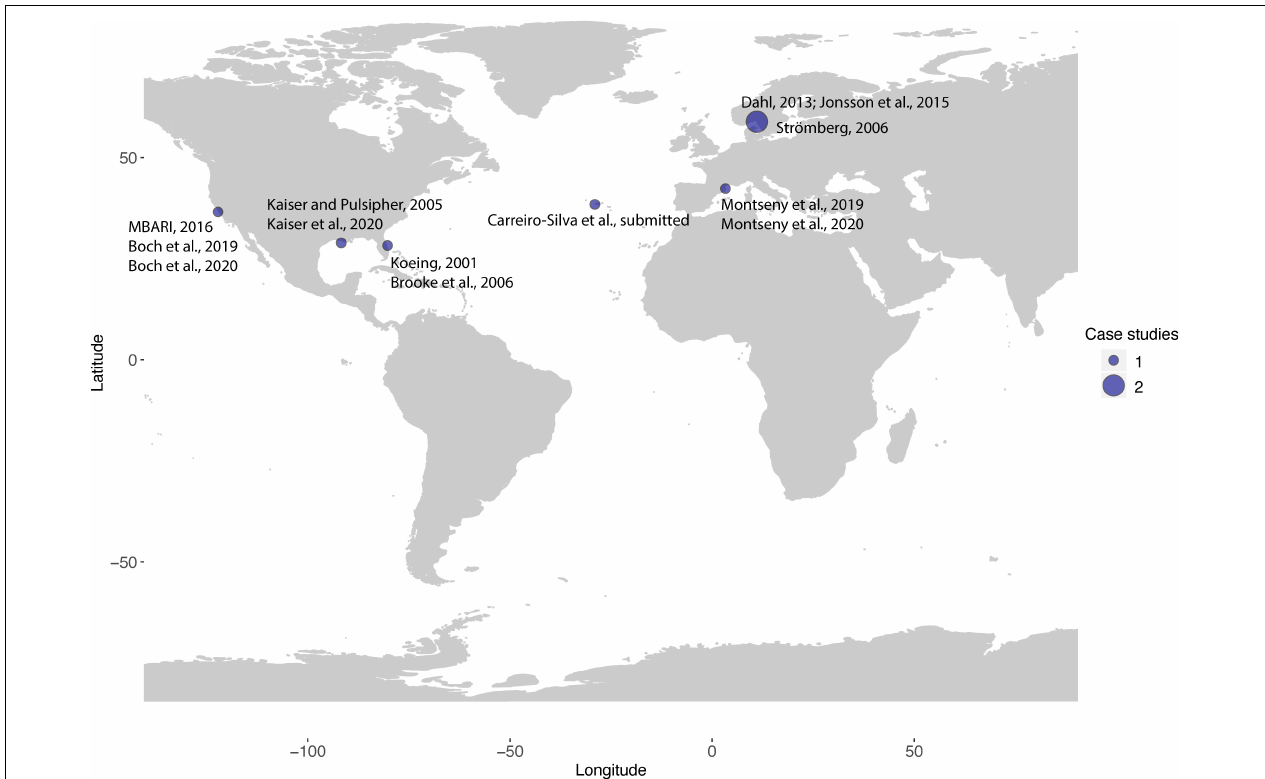
FIGURE 3 | Overview map of the worldwide locations of active restoration projects focused on CWC ecosystems. Circle size corresponds to the number of case studies in each site, up to August 2020 ( N =